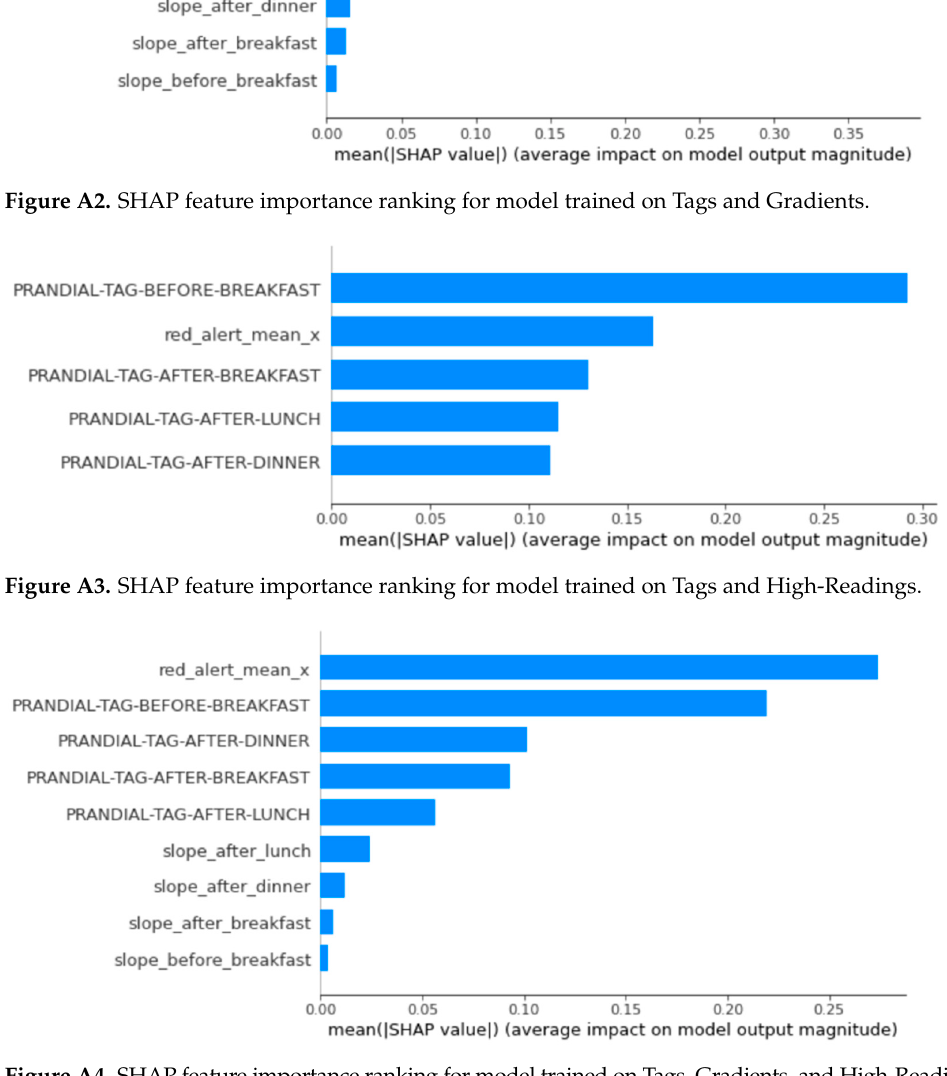
Figure A5. SHAP feature importance ranking for model trained on Tags and EHR features. Figure A6. SHAP feature importance ranking for model trained on Tags, Gradients, and EHR fea- tures.